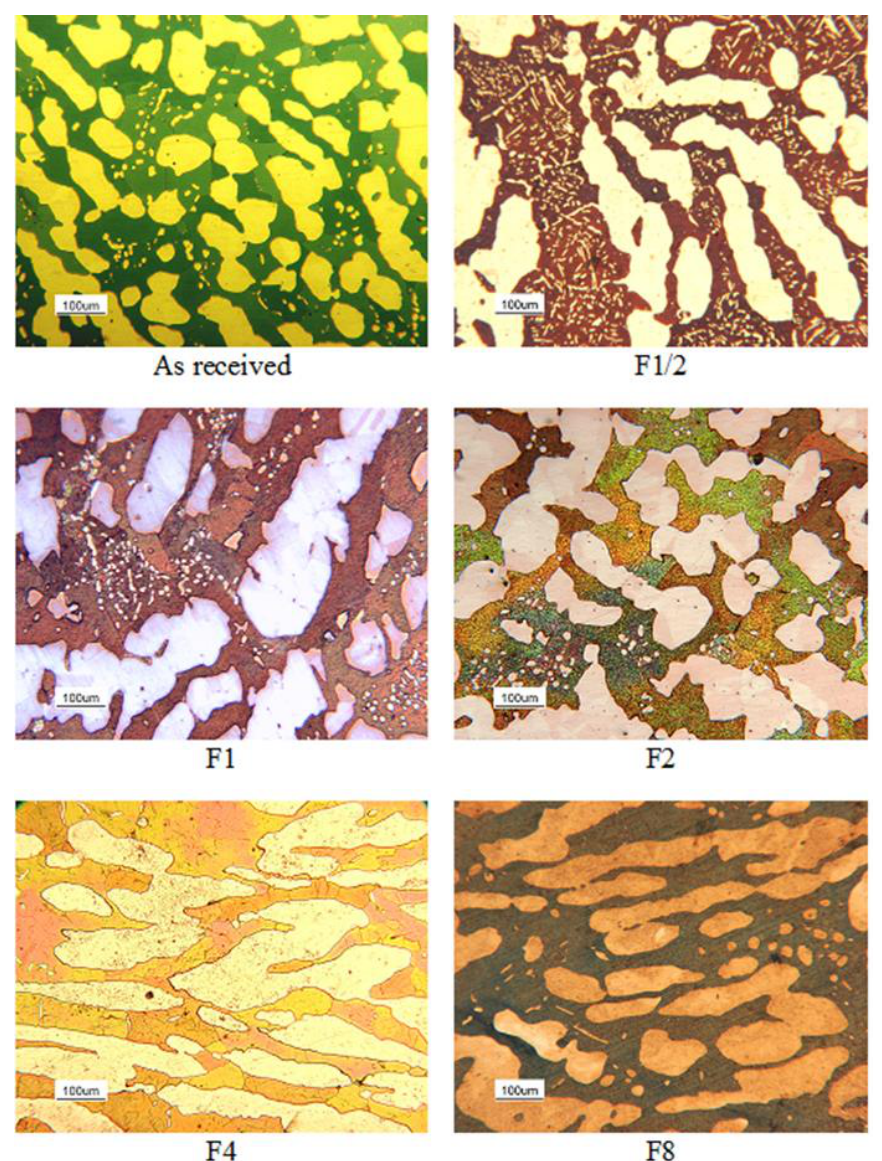
Figure 1. Microstructures of duplex stainless steel (DSS) 2205 thermal treated at 1050 °C for different soaking times.